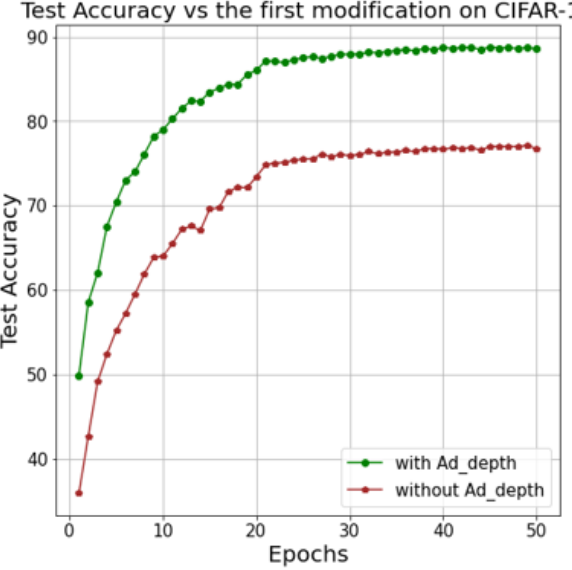
Figure 6. Comparison between Ad-MobileNet model with and without Ad-depth unit while con- serving the second (TanhExp function) and third